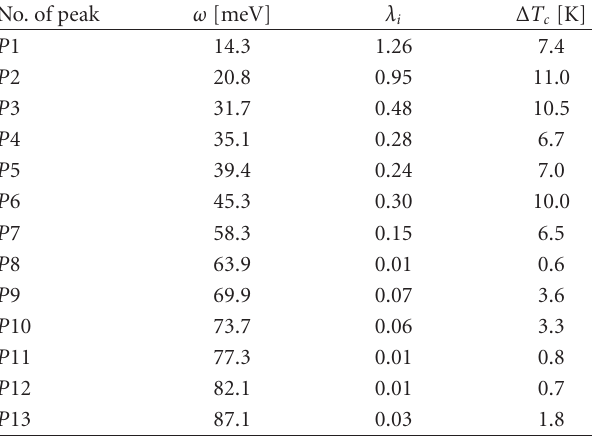
Table 1: Phonon frequency ω , EPI coupling constant λ i of the peaks P 1– P 13, and contribution Δ T c to T c of each peak in α 2 F ( ω )—as shown in Figure 24—obtained from the tunnelling conductance of Bi 2 Sr 2 CaCu 2 O 8 . Δ T c is the decrease in T c when the peak in α 2 F ( ω ) is eliminated. From [53,